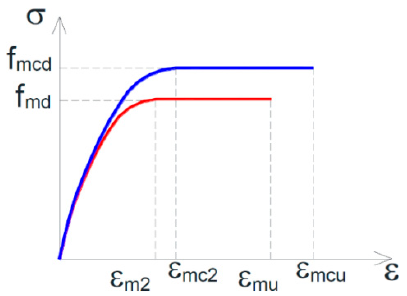
Figure 29. Design constitutive relationships of masonry: unreinforced masonry (URM) in red, confined masonry in blue [64].